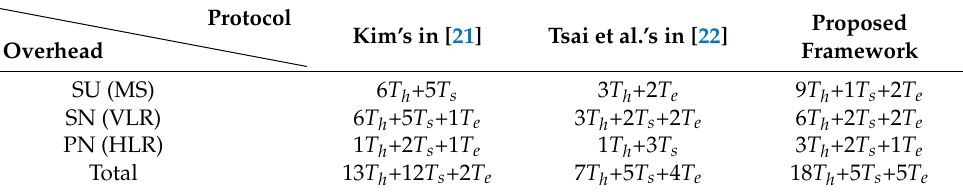
Table 5. Performance comparison among the related